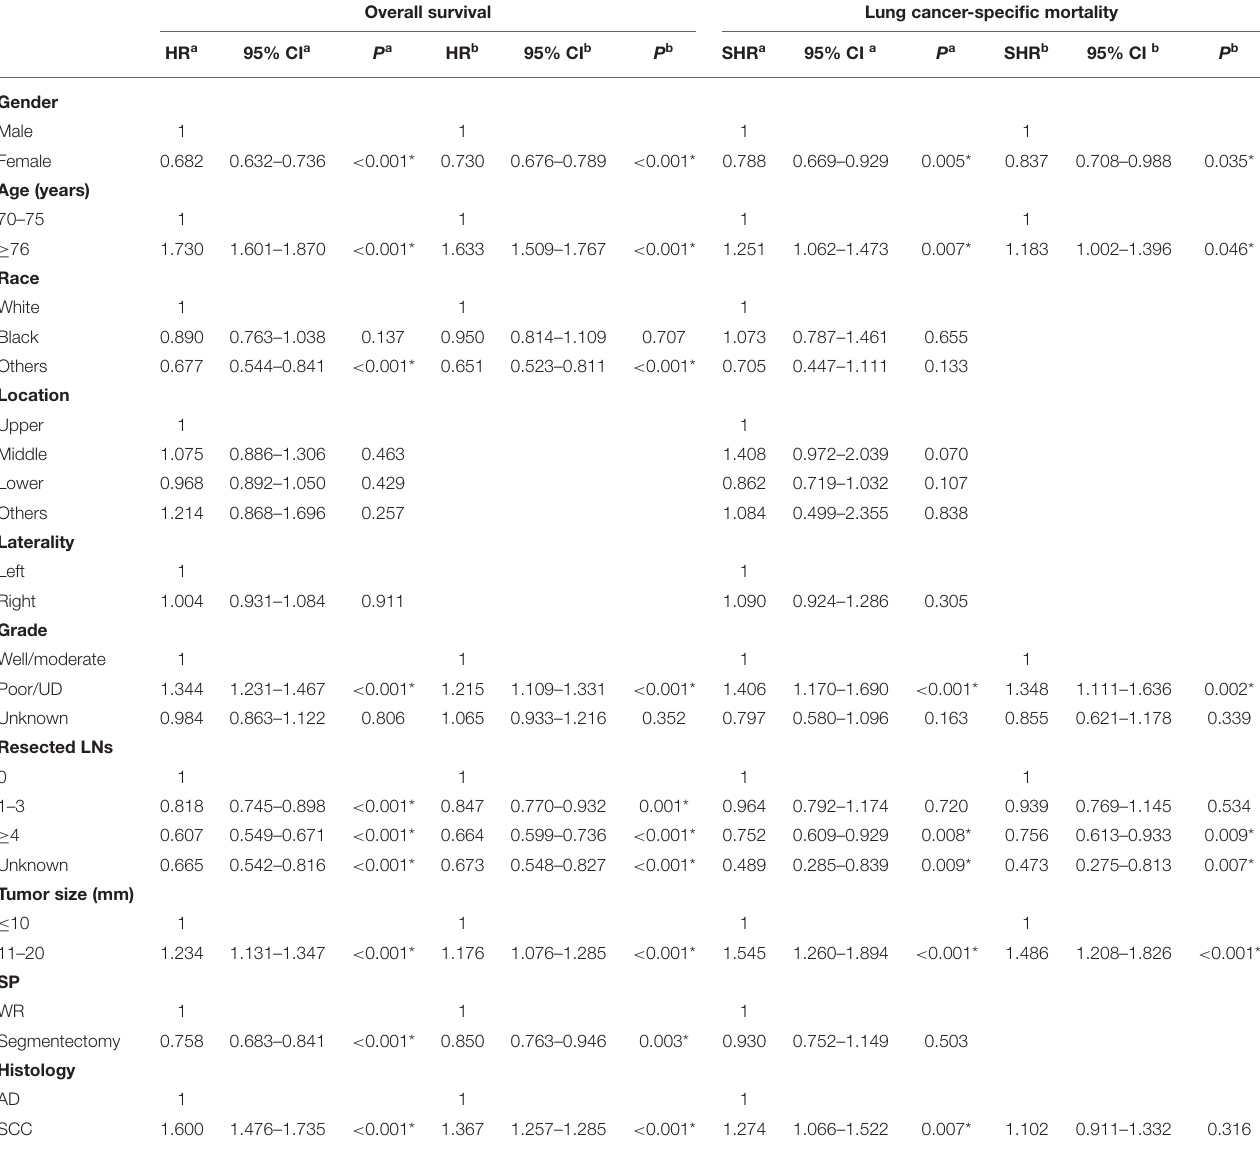
TABLE 2 | Survival comparisons for NSCLC patients with tumor size ≤ 20mm. Overall survival Lung cancer-specific mortality